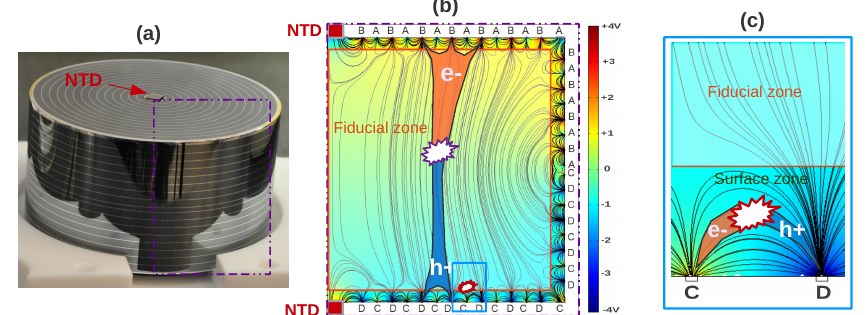
Figure 38: (a): An FID detector showing the interleaved ionization sensors and NTD sensor. (b): Cross-section of an FID detector illustrating the fiducial zone for an event generated in the bulk of the detector. (c): Illustration of charge collection for an event near the surface of the detector. Adapted from [ 63 ]